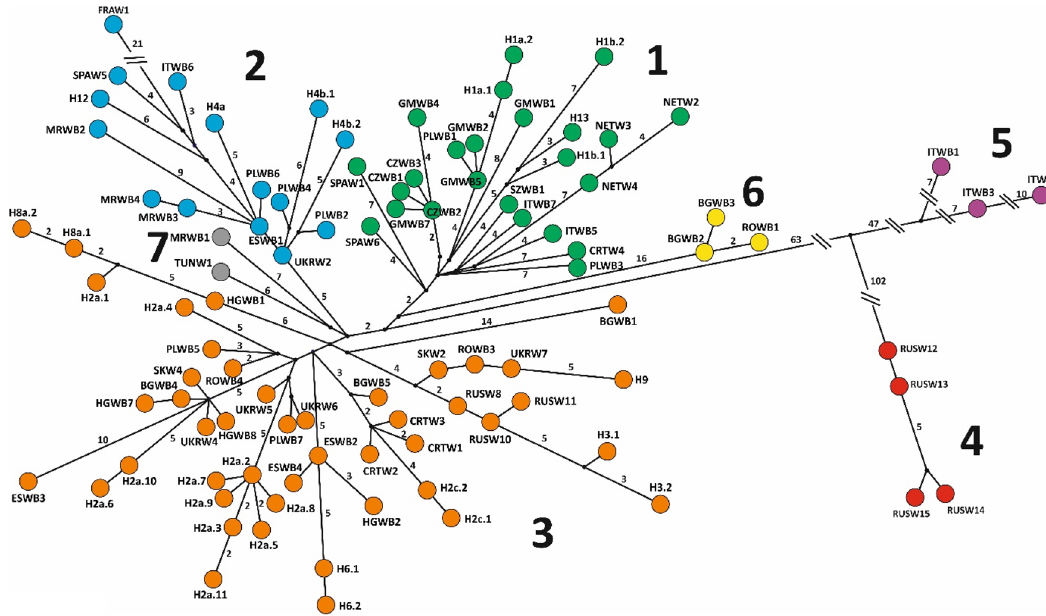
Figure 3. Haplotype network of the mitogenome sequences of wild boar from this study and Khederzadeh et al. 26 . Colours and numbers of clades as in Fig. 2. Numbers on branches mean mutation steps (if > 1) between